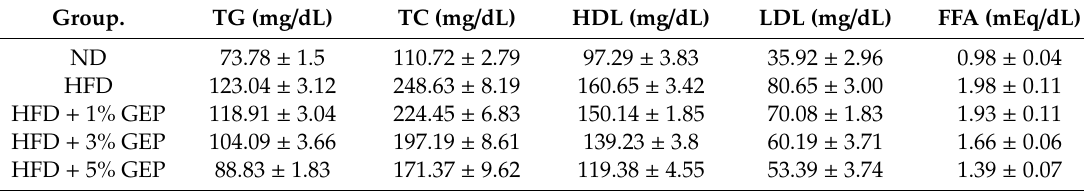
Table 5. E ff ects of G. lucidum extract on blood lipid and cholesterol levels. Table 5. Effects of G. lucidum extract on blood lipid and cholesterol levels. Group.